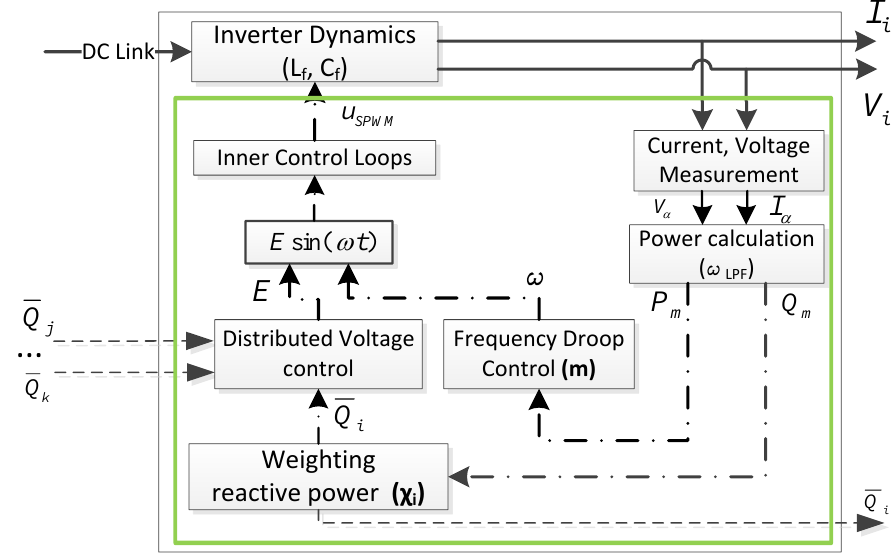
Figure 6. IDG CPES module (consensus protocol